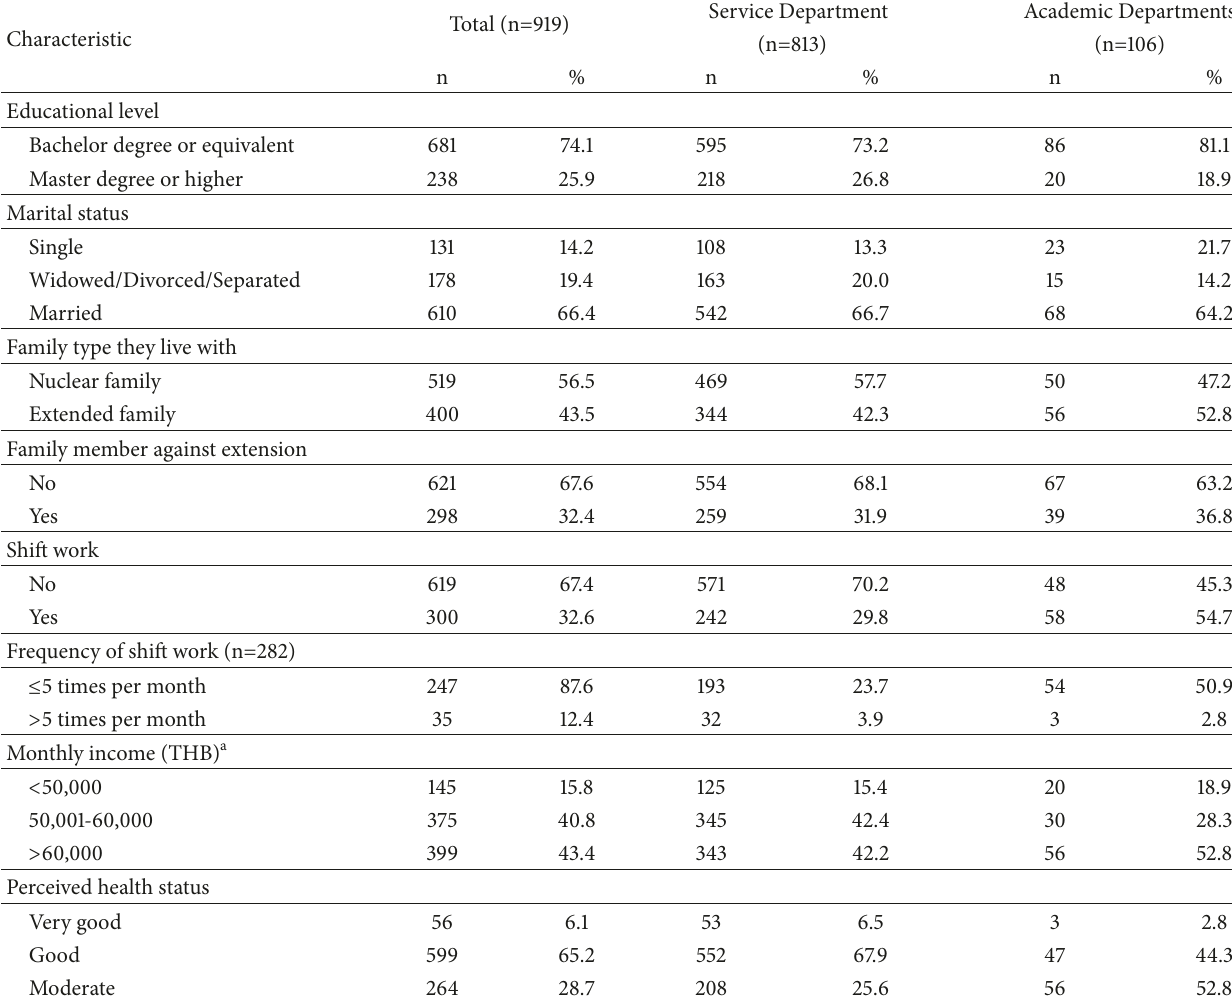
Table 2: Individual characteristics of registered nurses who intend to extend their working life until 65 years old (n=919).